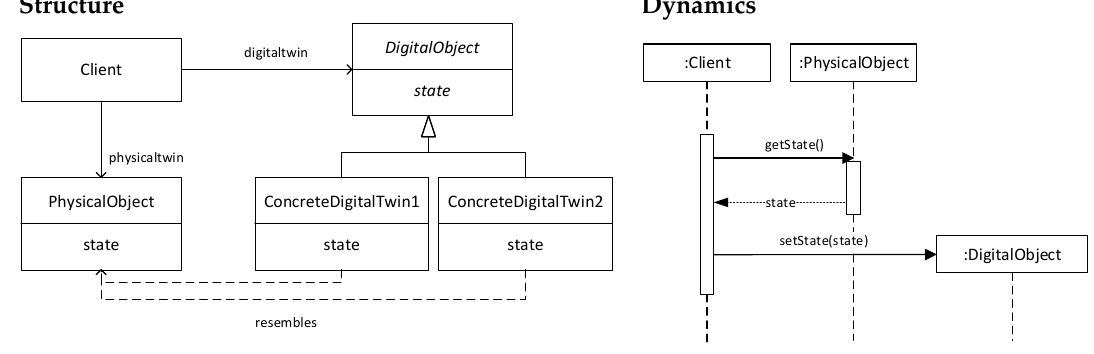
Figure 9. Digital Shadow pattern.